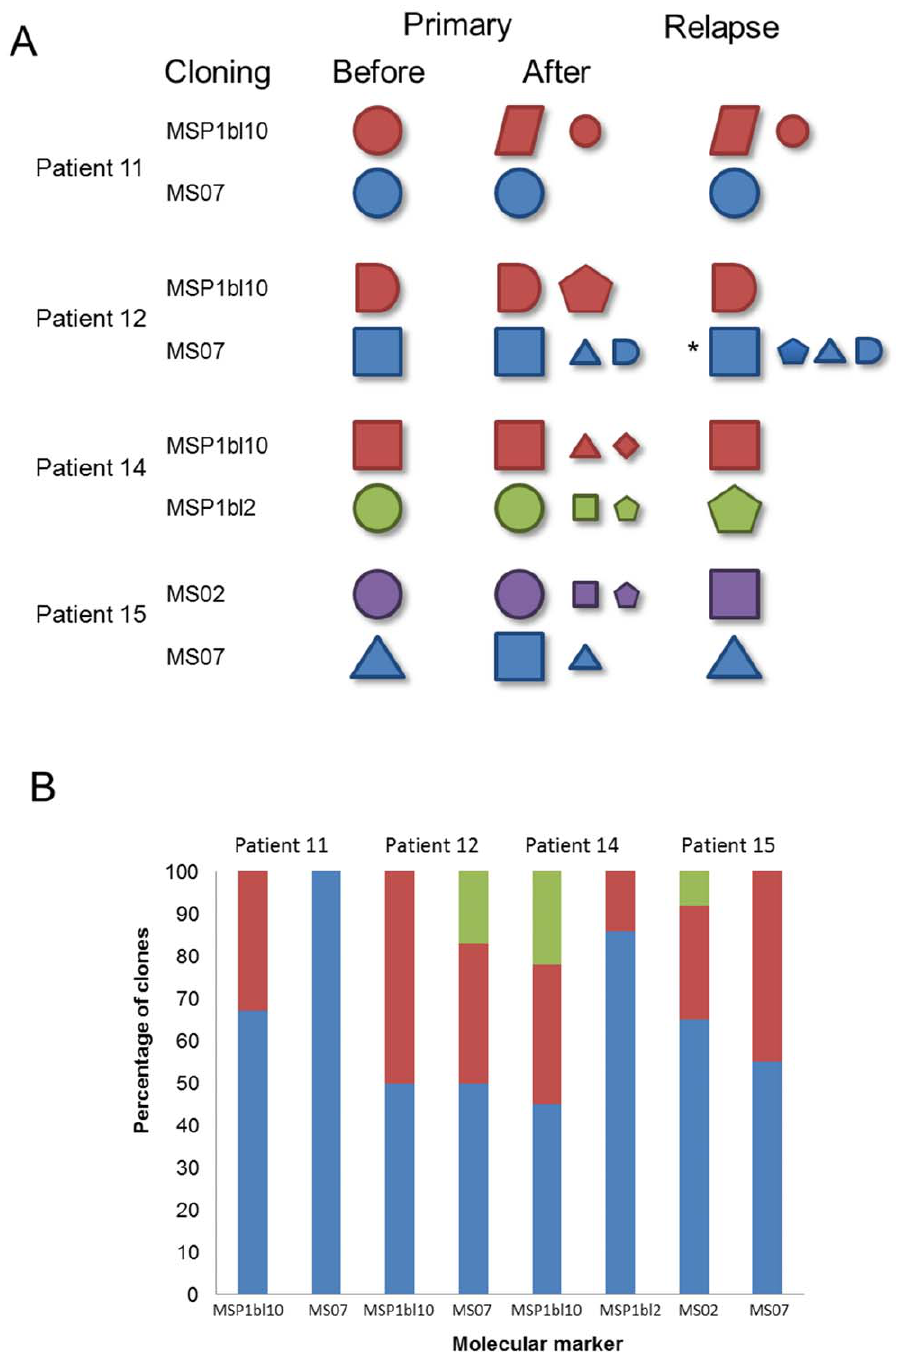
Figure 3. Genotypic profile before and after PCR cloning. PCR products from primary infection samples amplified using two randomly chosen molecular markers of four patients were cloned, and up to 26 colonies (mean of 11 colonies) were genotyped. (A) Each form represents an allele, size indicates predominant (larger) or rare alleles (smaller); color represents alleles of a distinct marker: MSP1bl10– red; MS07– blue; MSP1bl2– green; MS02– purple. The presence of two or more forms characterizes a multiple-clone infection. Before cloning the predominant allele was identified as the heighest peak in genotyping and the rare allele as the peak with one-third of the predominant peak height. After cloning the frequencies were inferred by the number of bacteria clones. The only relapse sample also cloned is indicated by an asterisk. (B) Frequency of each allele in primary infections after cloning measured by the percent of bacterial colonies genotyped with each allele (represented by different colors). doi:10.1371/journal.pone.0049871.g003 observed in the majority of markers. For all alleles (predominant 10.8 6 2.7 for the predominant and all alleles, respectively, without including MS11 data, and 11.4 6 7.3 and 13.4 6 8.7 with MS11 and rare), this frequency increased from 40 to 77% (Fig. 1B). This data. A high frequency of predominant alleles of the same size was finding reflects variation in how well the technique could detect